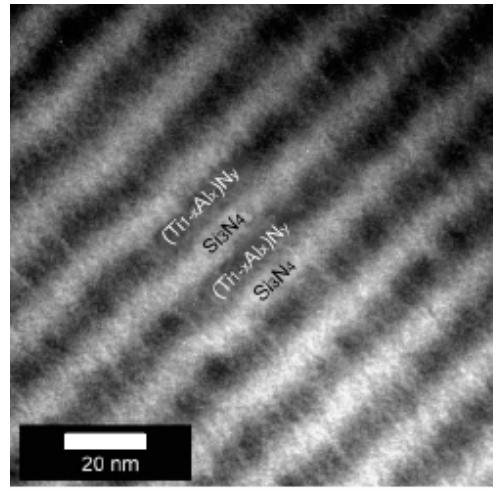
Figure 27: Ti-Al-Si-N multilayer coating having Ti-Al-N and Si 3 N 4 alternate periodic layers [303]